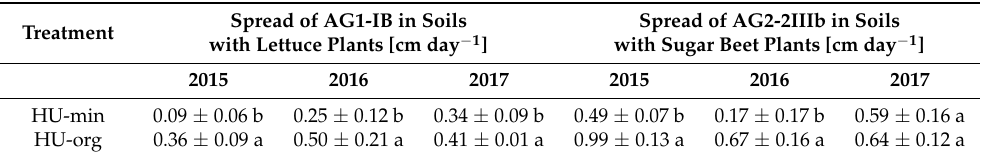
Table 1. Disease spread of Rhizoctonia solani AG1-IB in lettuce (cv. Tizian) and of R. solani AG2-2IIIb in sugar beet (cv. Lisanna) 12 days after inoculation of the respective pathogen in soils sampled from HUB-LTE in 2015, 2016 and 2017. Small letters indicate significant differences between long-term mineral (HU-min) and organic (HU-org) fertilization using the procedure ROBUSTREG ( p < 0.05). Spread of AG1-IB in Soils Spread of AG2-2IIIb in Soils Treatment with Lettuce Plants [cm day − 1 ] with Sugar Beet Plants [cm day − 1 ]